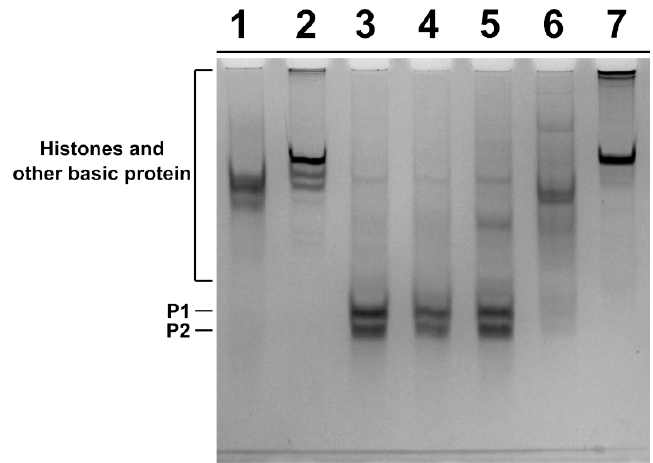
Figure 2. Characterization of human SNBP from samples belonging to two individuals of L-group (controls) and a father and his son living in the “Land of Fires”. AU-PAGE of SNBP of: rabbit total histones(lane 1); sea urchin total histones (lane 2); human control 1 and 2 samples, showing the CP/Hr (lanes 3–4); son sample showing the nCP/Hr (lane 5) and father sample showing only-H (lane 6); calf thymus H1 histone (lane 7). SNBP: sperm nuclear basic proteins; L-group: low impact area group; CP/Hr: canonical protamines/histones ratio; nCP/Hr: non-canonical protamines/histones ratio; only-H: only histones and other basic proteins.